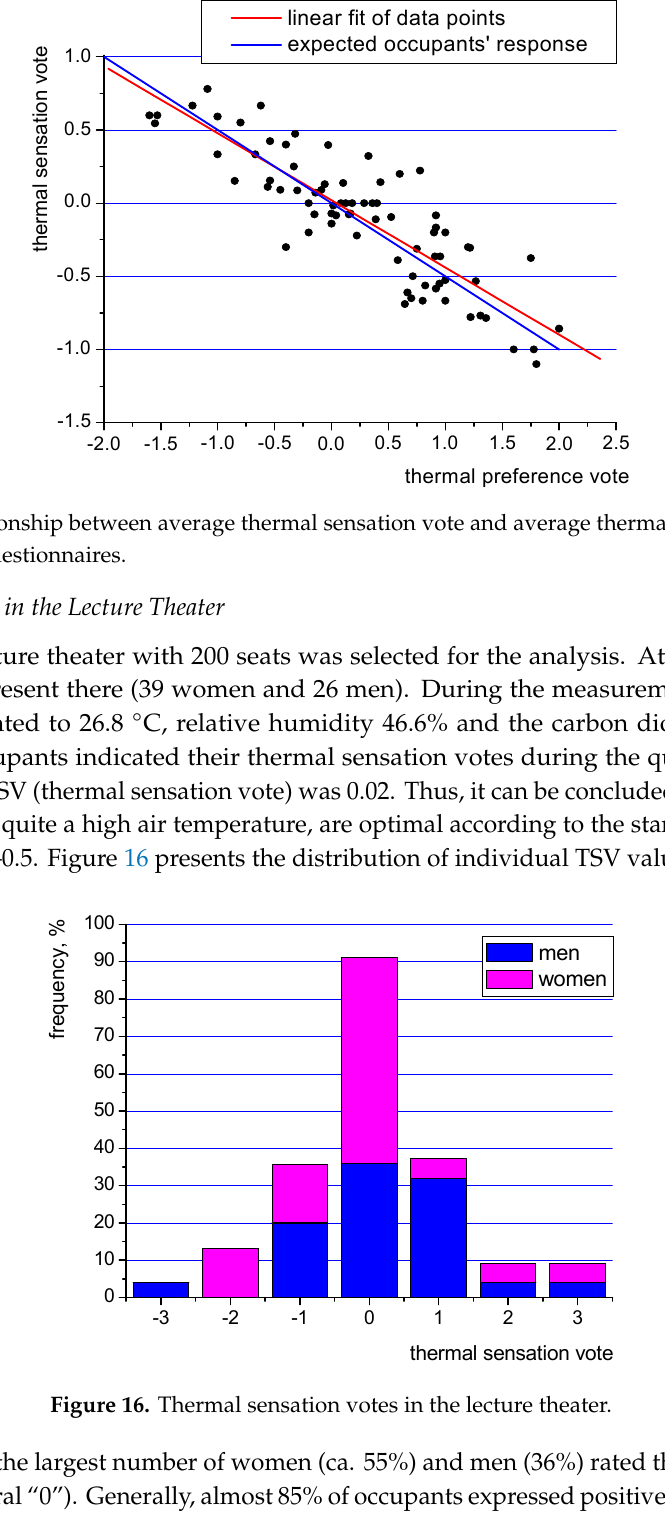
Figure 16. Thermal sensation votes in the lecture theater.